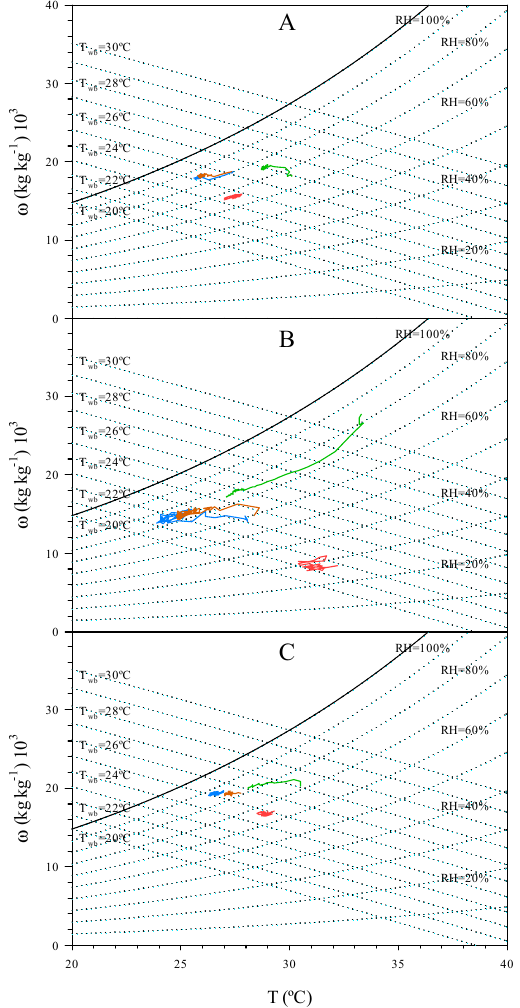
Figure 13. The state of the air outside (red), in the pre-chamber (blue), at the air duct end (orange) and in the greenhouse (green) during the fan-pad (P) system tests combined with roof ventilation (V) and shading (S) (( A ): Test 6, P + V; ( B ): Test 7, P + S; ( C ): Test 8, P + V + S). Table 5. Average values and standard deviation of the different fan-pad system operating parameters. The tests analysed are the fan-pad system (P) together with roof ventilation (P + V, test 6), with shading (P + S, test 7) and with both (P + V + S, test 8).